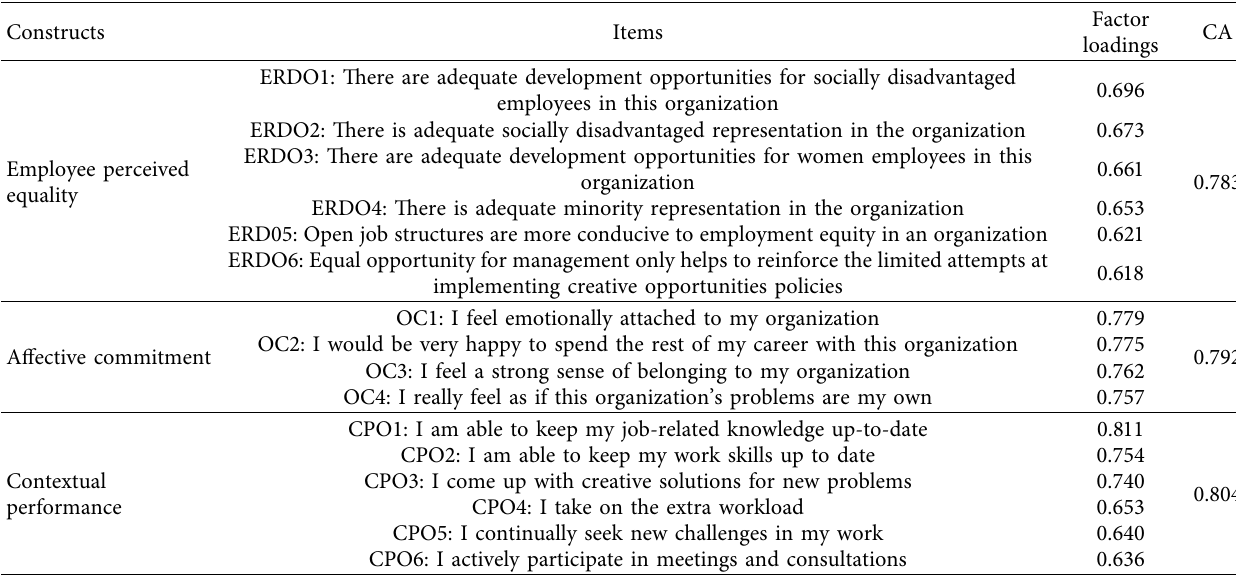
Table 5: Measures of latent variables.